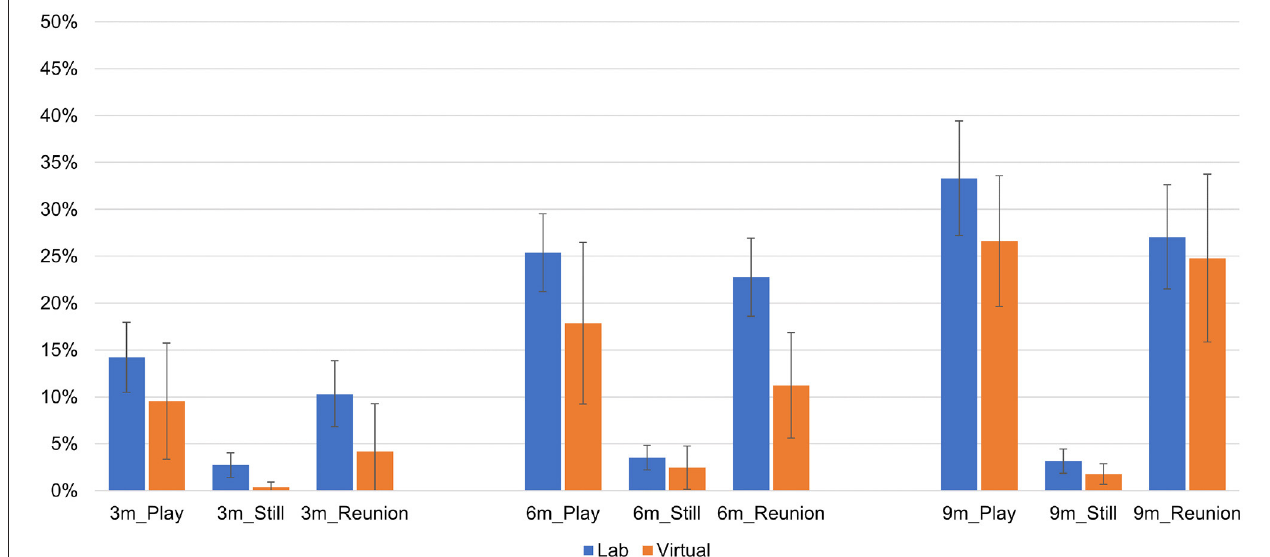
FIGURE 5 | Infant positive affect at each time point as a function of Still Face episode and visit type.